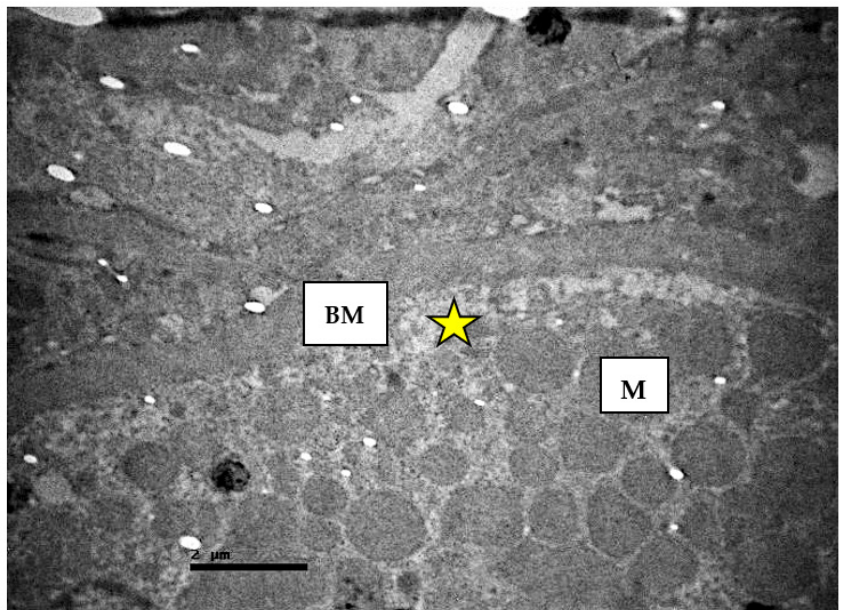
Figure 12. Renal convoluted tubules of non-resuscitated swine sample. The basement membrane of the epithelium shows thickness (BM) and disorganization of basal membrane invaginations (yellow star). Enlargement of the mitochondria (M) is also observed.